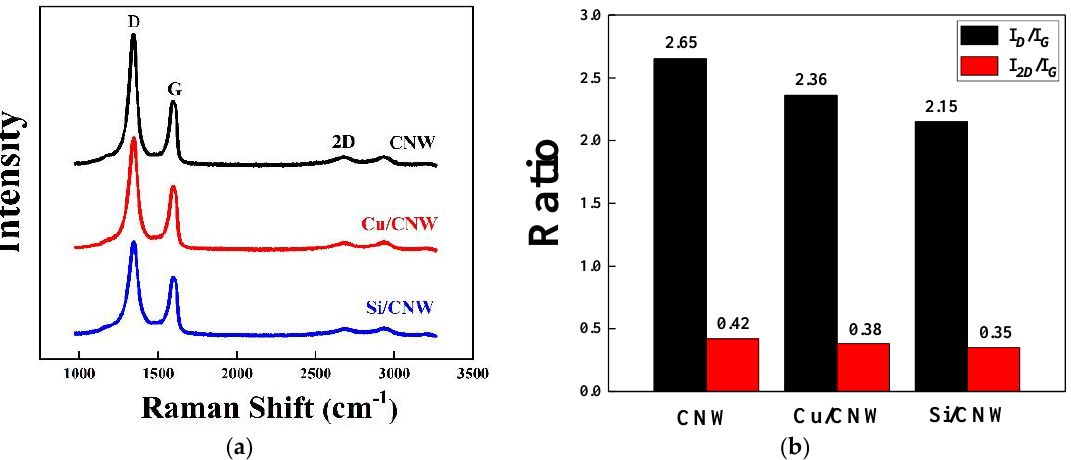
Figure 6. ( a ) Raman shift of the CNW, Cu − CNW, and Si − CNW, ( b ) I D /I G ; and I 2D /I G ratio of CNW, layer − coated CNWs from Raman shift.